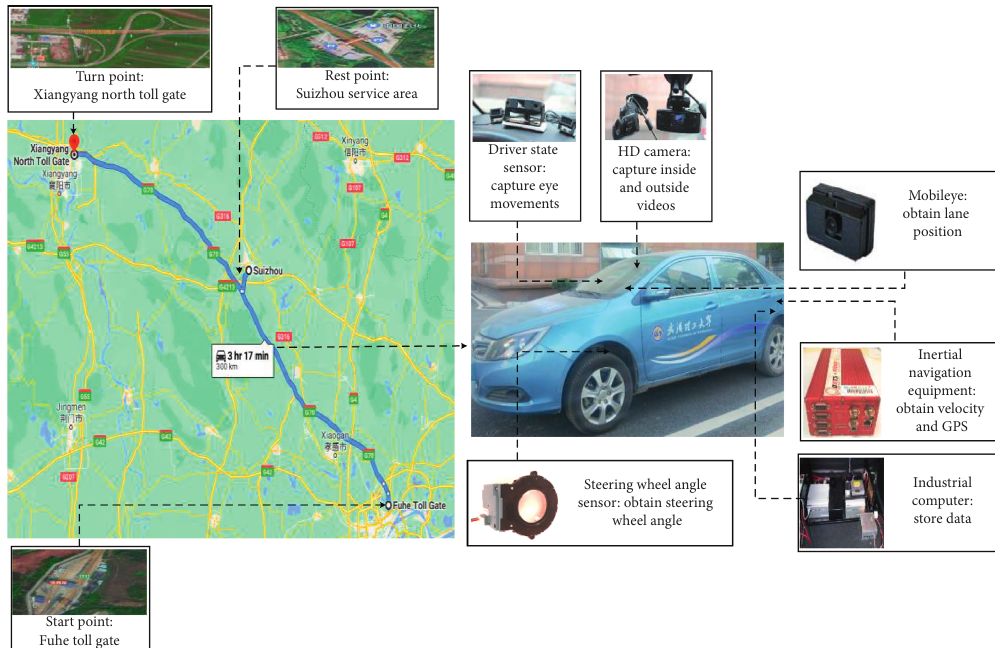
Figure 1: Diagram of experiment apparatuses and